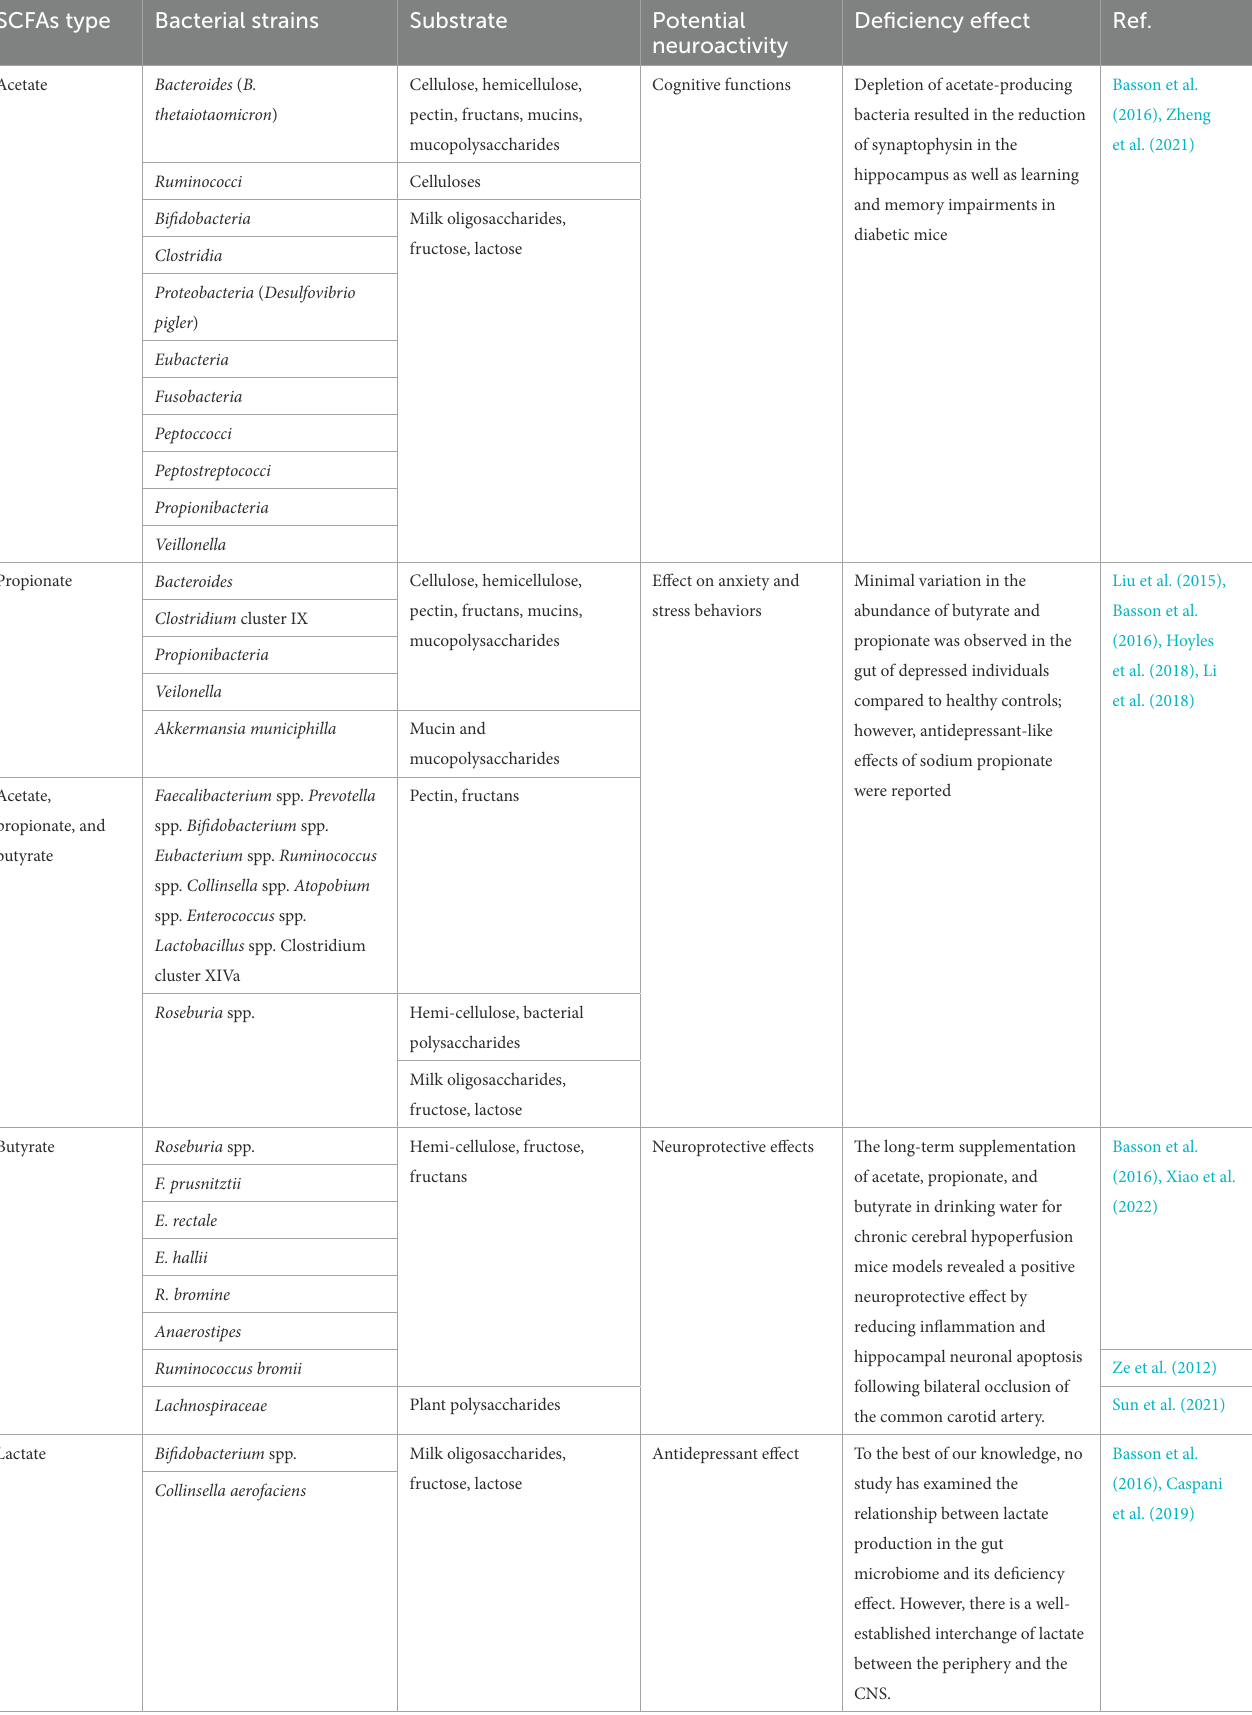
TABLE 1 SCFAs-producing microorganisms and substrates associated with bacterial fermentation. SCFAs